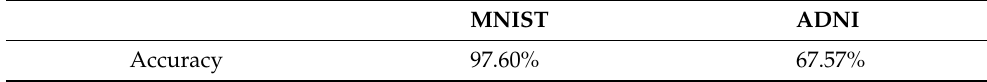
Table 3. The accuracy on MNIST and ADNI dataset without differential